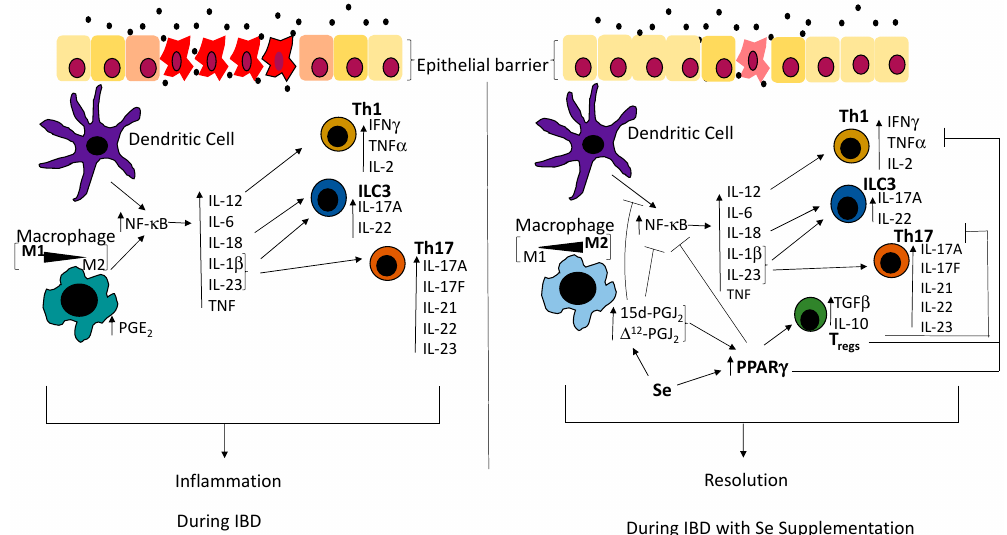
Figure 1. Schematic showing disruption of the epithelial barrier results in activation of immune networks that are regulated by Se. Consequently, innate immune cells such as macrophages and dendritic cells sense the presence of the bacteria and mount an immune response through the upregulation of the transcription factor, nuclear factor-kappa B (NF- κ B), leading to the production of pro-inflammatory cytokines such as interleukin (IL)-18 and interleukin (IL)-12, as well as IL-1 β and IL-23, which are involved in the differentiation of innate lymphoid cells (ILC3s), Th1 and Th17 cells respectively [36]. In the presence of Se, macrophages produce 15d-prostaglandin J 2 (15d-PGJ 2 ) and ∆ 12 -prostaglandin J 2 ( ∆ 12 -PGJ 2 ). The nuclear hormone receptor, peroxisome proliferator-activated receptor gamma (PPAR γ ), is upregulated and inhibits Th1, Th17 as well as the action of NF- κ B, thus inhibiting the production of the pro-inflammatory cytokines that are required for the differentiation of T helper cells and ILC3s. Simultaneously, PPAR γ leads to the differentiation of T regs , which inhibit the function of T helper cells. As 15d-PGJ 2 and ∆ 12 -PGJ 2 are ligands of PPAR γ , they bind to PPAR γ and potentiates its action on NF- κ B and T regs , as well as directly inhibit the activation of NF- κ B. Commensal bacteria are represented by filled black circles. IFN γ : ： interferon gamma; TNF α tumor